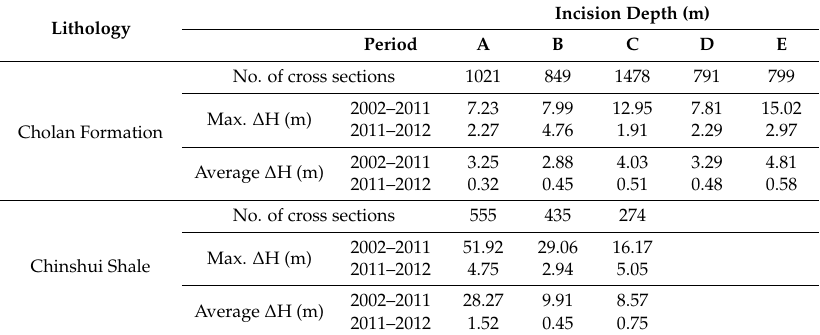
Table 3. Gully incision depth calculation results using the continuous swath profiles selection method.